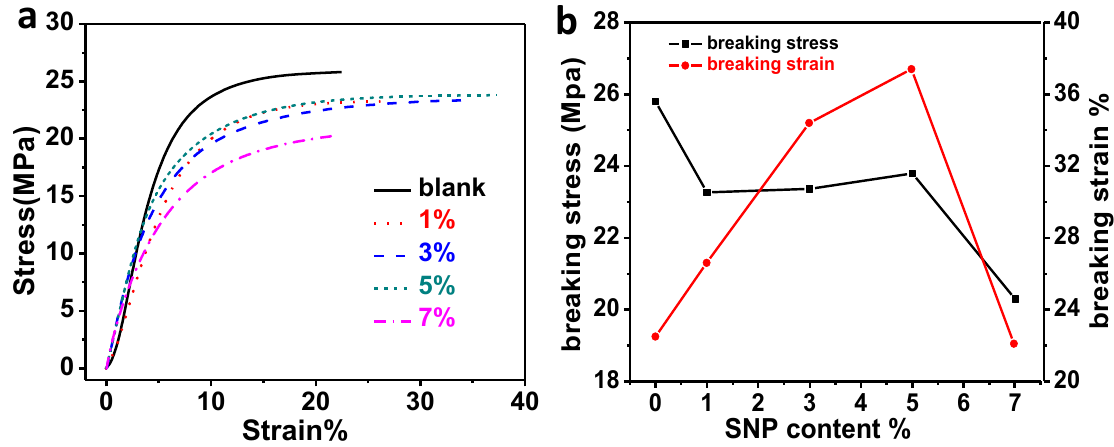
Figure 3. Stress-Strain curves and breaking stress/strain plot of xLCNs/SiO (xLCN/SNP) and blank xLCN samples at 30